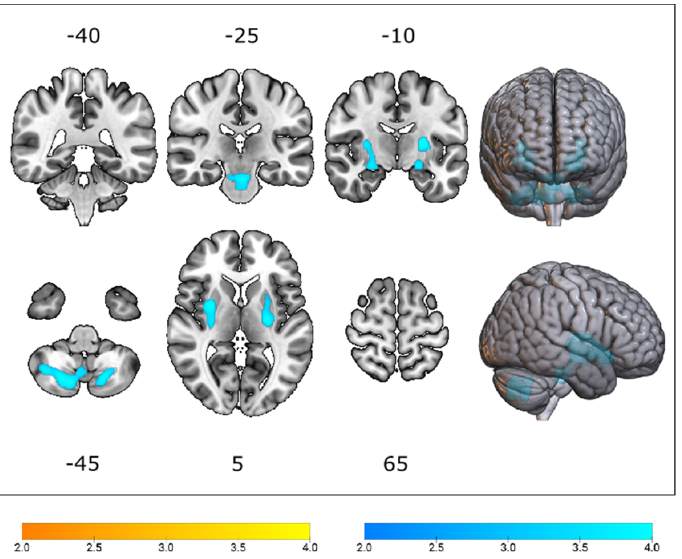
Figure 2. T-statistical map detailing patterns of relative hypometabolism (yellow) and hypermetabolism (blue) in C9orf72 -ALS patients, when compared to SOD1 -ALS patients, thresholded at p uncorr < 0.001 at voxel level, and p FWE < 0.05 at cluster level, while correcting for age, sex, scanner type and King’s disease stage. Clusters are overlaid on a T1-weighted template.